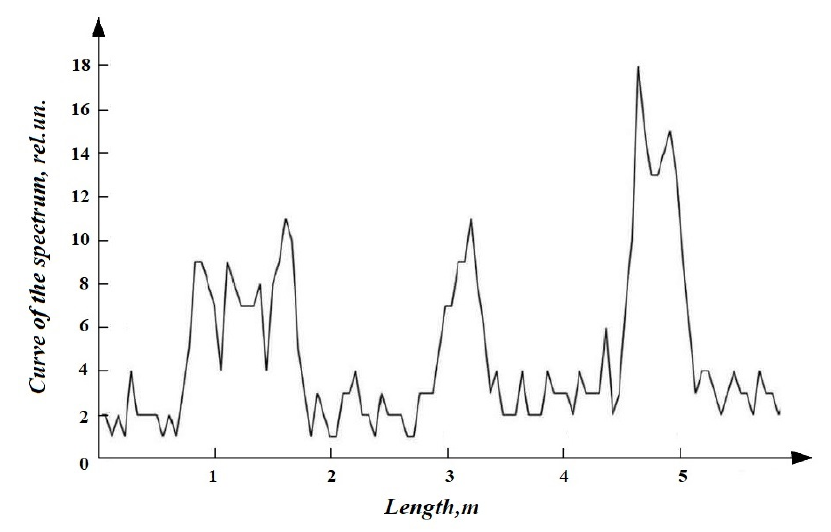
Figure 7. Synthetic radargram of the model (Figure 4a).